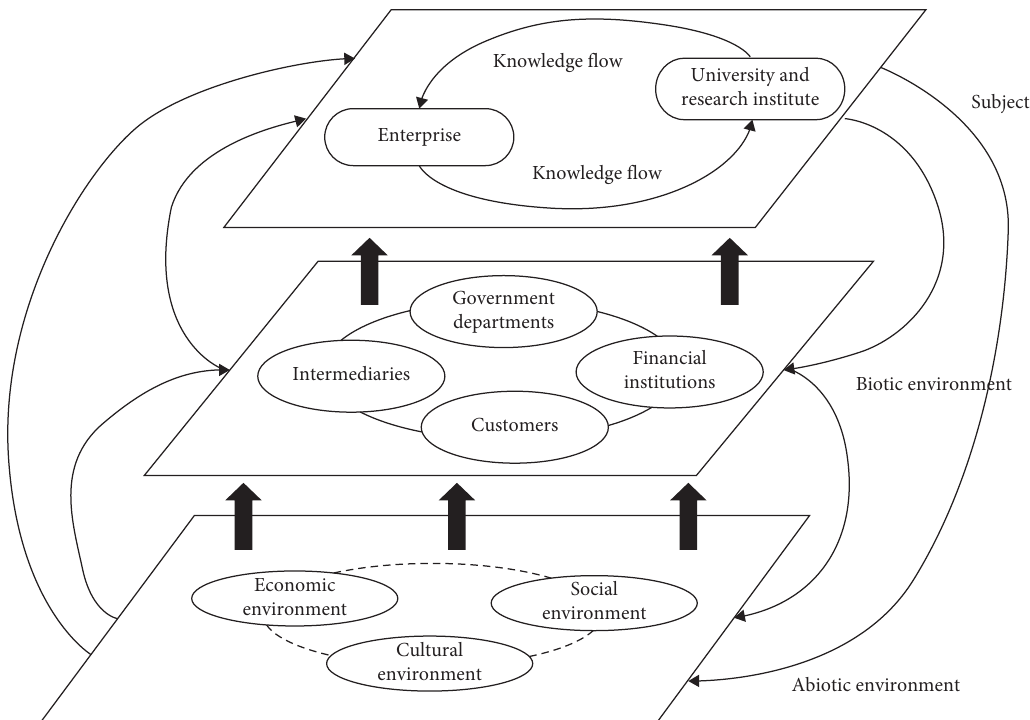
Figure 1: The structure of EIE (enterprise innovation